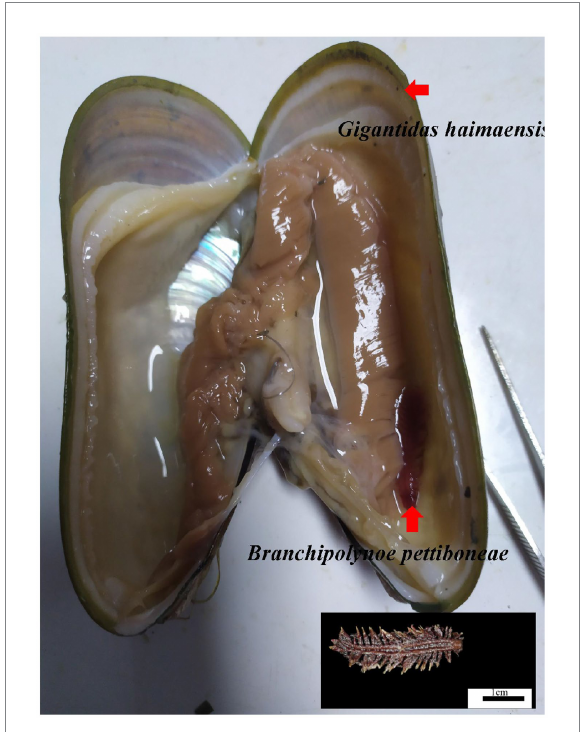
FIGURE 1 Photograph of the scale worm Branchipolynoe pettiboneae and its host deep sea mussel Gigantidas haimaensis. Shell length of the G. haimaensis is 8.2